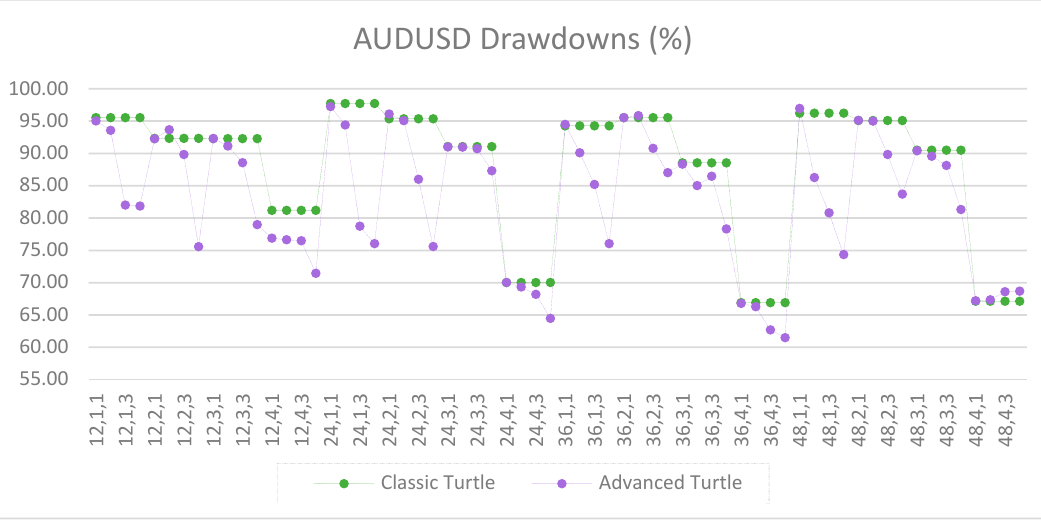
Figure A18. Drawdowns of AUDUSD as percentage of equity between the classic and the advanced Turtle systems for every combination of N, X, Y for the medium parameters (40, 80).